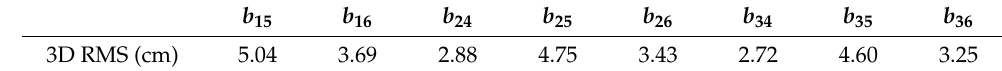
Table 5. The 3D RMS position errors of the baselines across the two cells using all satellites in view and the broadcast integer ambiguities of the proposed framework.